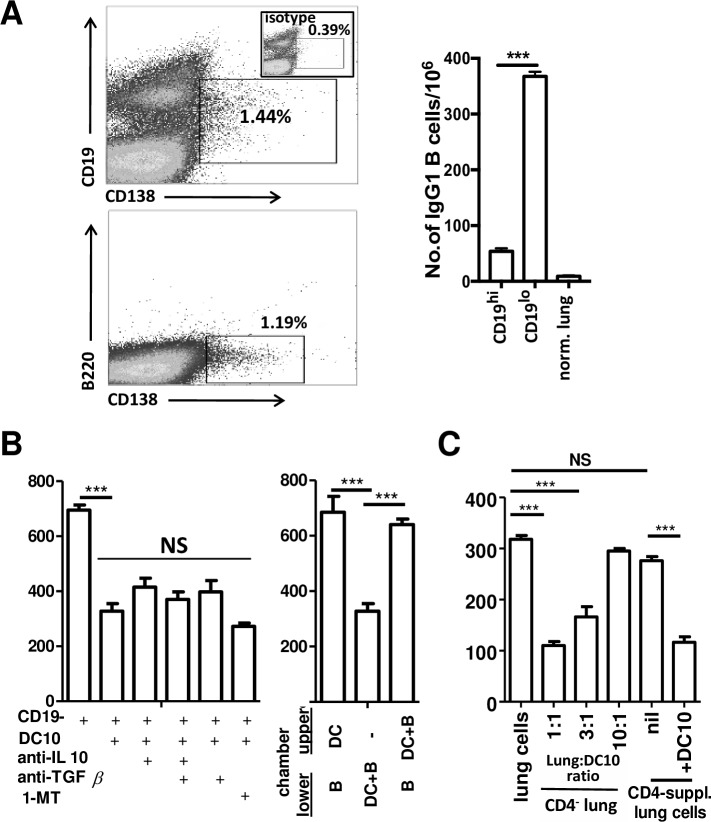
DC10 suppression of the IgG1 B cell response does not dependent on secreted mediators or T helper cells, and is contact-dependent.(A, left panel) Enzymatically-dispersed asthmatic lung single cell suspensions generated as in Fig 3 were analyzed by FACS for expression of CD19, CD138 and B220 using specific fluorochrome-labelled antibodies. The analysis was restricted to lymphocytes as assessed by forward- and side-scatter characteristics, and the gates set using irrelevant isotype control antibodies (eg, inset in the top panel). (right panel) The lung cells were magnetically-sorted using CD19-specific paramagnetic beads into CD19+ and CD19-/lo populations, each of which was assessed directly in 5 h ELISPOT assays for OVA-specific IgG1-secreting cells. As expected, the vast majority of IgG1 secretion was associated with the CD19-/lo population; unfractionated healthy lung single cell suspensions were also assayed for IgG1-secreting cells as a negative control. (B, left panel) DC10 were cultured in standard tissue-culture plates with asthmatic CD19-depleted lung cells (1:1 lung cell:DC10 ratio) either as is, or in the presence of anti-IL-10 and/or anti-TGFβ antibodies or the indoleamine-2,3-dioxygenase inhibitor 1-methyltransferase (1-MT) for 24 h and then transferred into ELISPOT plate for 5 h to assess for residual IgG1 secretion as above. None of these treatments significantly impacted DC10-dependent suppression of IgG1 secretion (p>0.05). (B, right panel) The need for direct B cell:DC10 contact was assessed using transwell approaches, with the cells either in different (i.e., upper versus lower) transwell chambers or in the same chamber for 24 h, and then cells on the bottom chamber were transferred into ELISPOT plates for 5 h. Whether direct DC10-B cell contact in the upper chamber induced the secretion of a soluble mediator(s) that could suppress IgG1 secretion by B cells in the lower chamber was also assessed. DC10-mediated suppression of IgG1 secretion was contact dependent, and not mediated by secreted mediators. (C) CD4+ T cell-depleted lung cells of asthmatic BALB/c mice (CD4- lung cells) were co-cultured with varying numbers of OVA-presenting DC10 for 24 h, and then transferred into ELISPOT plates and assayed for B cell IgG1 production as in panel B. We also examined the impact of adding purified asthmatic lung CD4+ T cells back into these CD+ T cell-depleted lung cells in numbers equivalent to those seen in the asthmatic lung (i.e., 19%) and assessed the impact of DC10 co-culture with those cells. The CD4+ T cell-depleted lung cells contained as many OVA-specific IgG1-producing B cells as did the lung cells reconstituted with purified CD4+ T cells, indicating that the CD4+ T helper cells were dispensable for IgG1 production, and had no impact on DC10 suppression of this response. The data is presented as the mean number of antibody-secreting cells/106 input cells (±SEM) in 4 wells/sample, and is representative of three independent experiments (n = 4/group). Statistical analyses were performed using t-tests (paired) and one-way ANOVA assays with Tukey’s post-hoc testing. *** and NS signify p<0.001 or p>0.05, respectively.